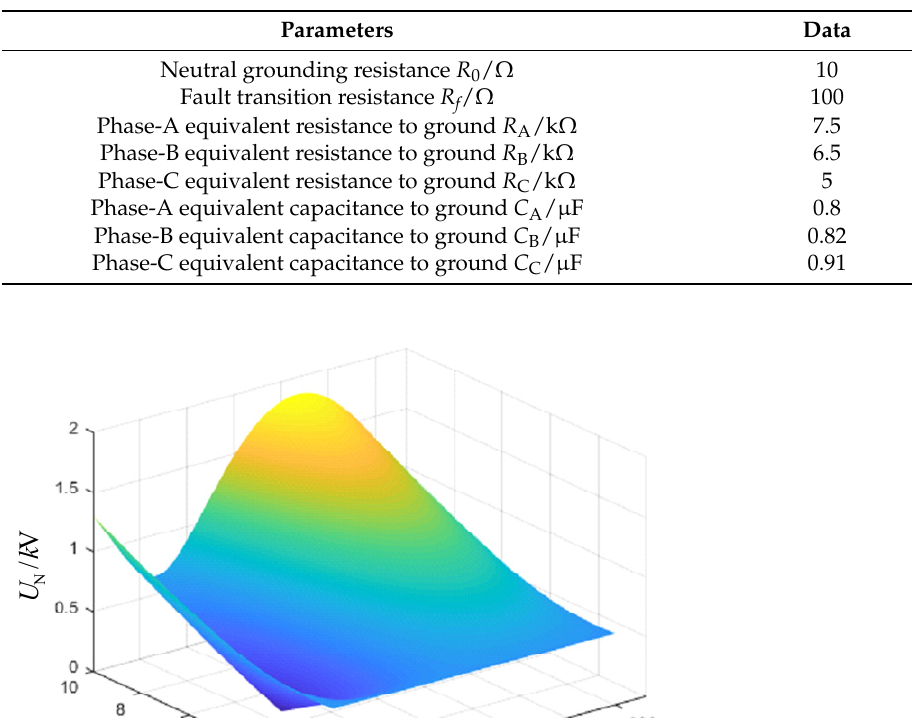
Table 1. Parameter settings.